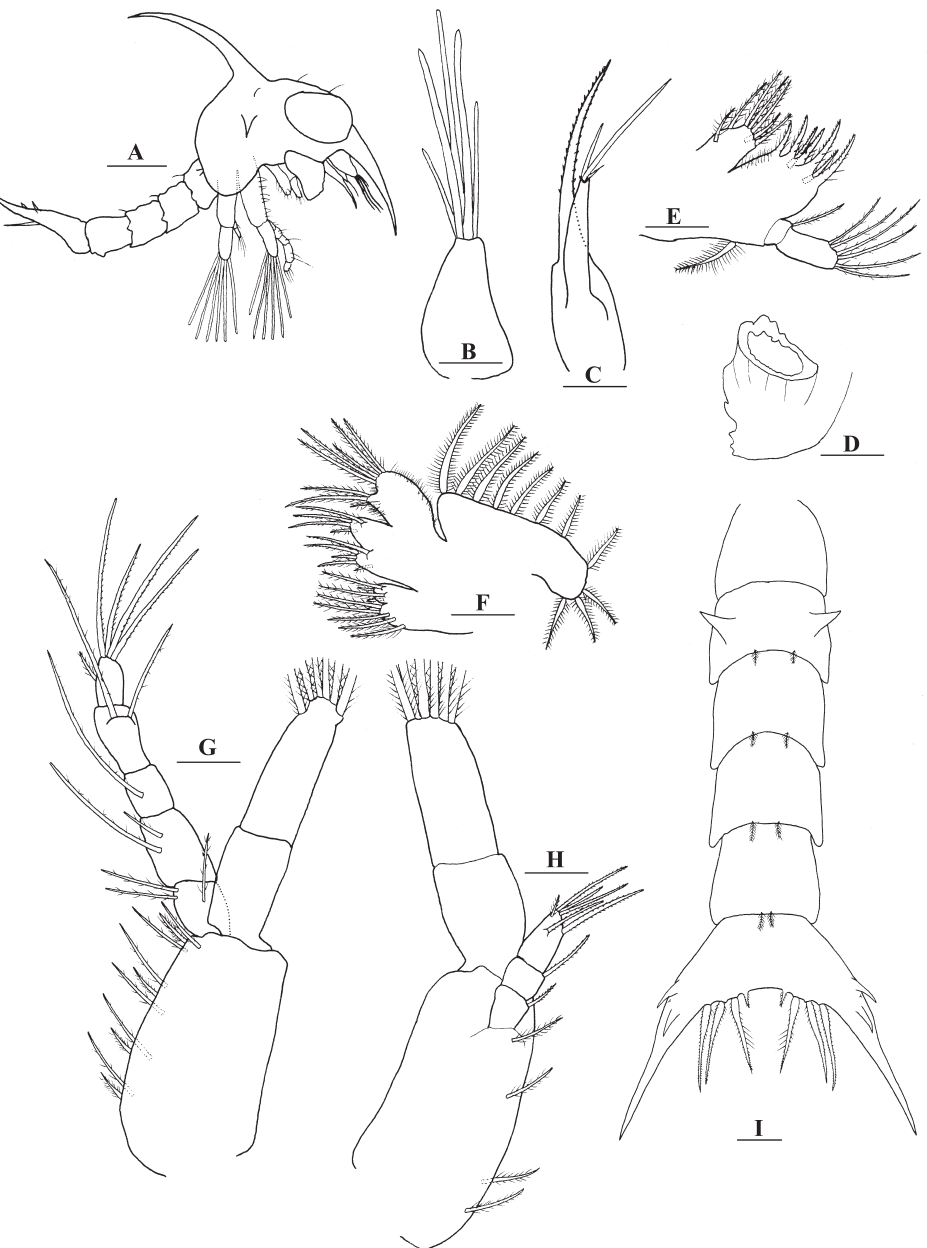
Fig. 2. – Pilumnoides hassleri . Zoea ii. A, whole animal, lateral view; B, antennule; C, antenna; d, mandible; e, maxillule; F, maxilla; G, first maxilliped; h, second maxilliped; i, abdomen. scale bars. A, 0.2 mm; B-h, 0.05 mm; i, 0.1